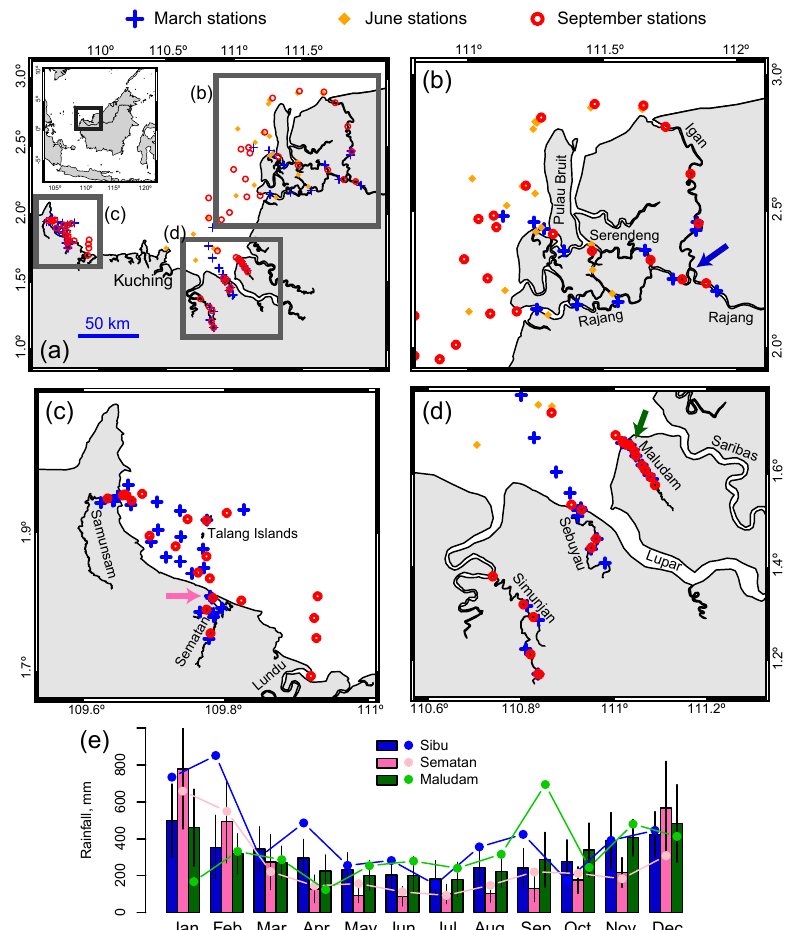
Figure 1. (a) Map of the study region showing station locations for each of the three expeditions. Thick grey boxes with letters indicate the areas shown in panels (b–d) . (e) Monthly mean precipitation for the towns of Sibu, Sematan, and Maludam (locations of the rain gauges are marked with arrows in panels b , c , and d ; arrow colours correspond to the bar colours in panel e ). Bars show mean ± 1 SD for 1999–2017, while points show values for 2017. Bars and points for the three locations in each month are separated horizontally for better readability but correspond to the same time